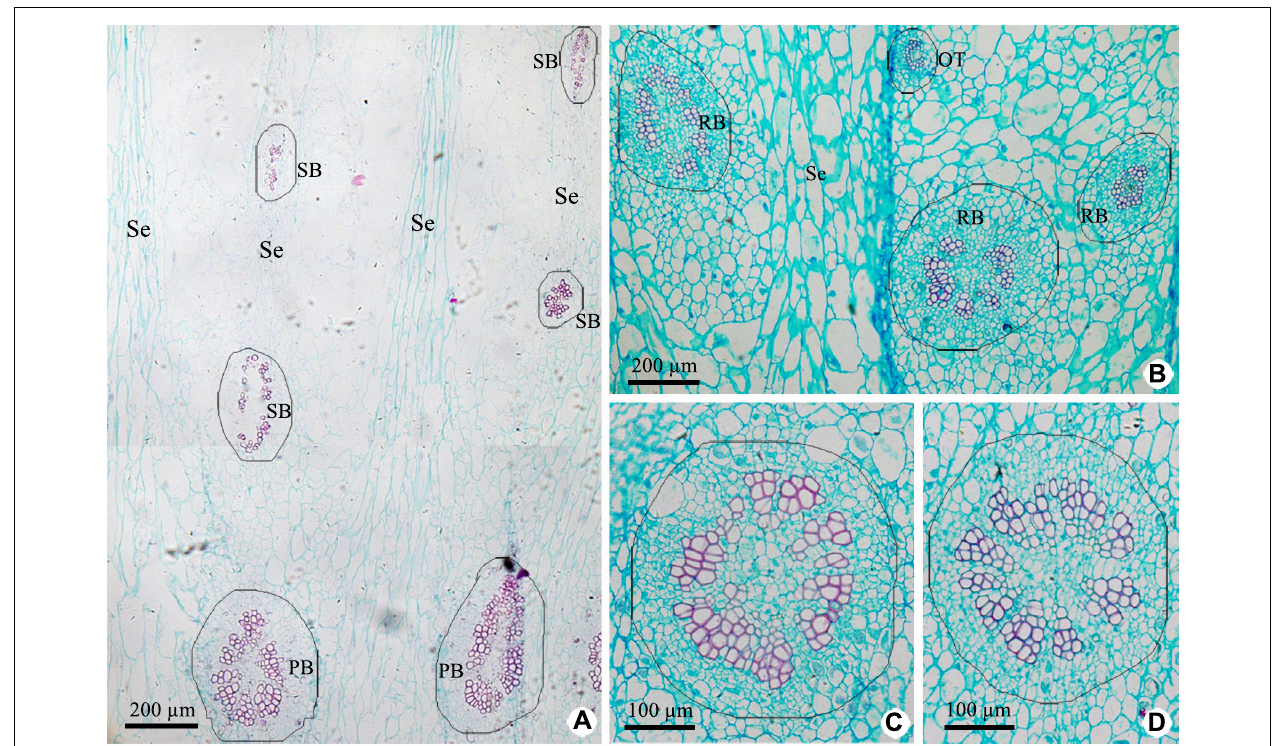
FIGURE 3 | Cross sections of peripheral placenta at the base of fruits showing the distribution, shape, type, and structure of amphicribral vascular bundles. (A) Distribution of vascular bundles at placental periphery, showing placental vascular bundles at the periphery of axile placenta and septum vascular bundles in every other septum. (B) Cross section showing